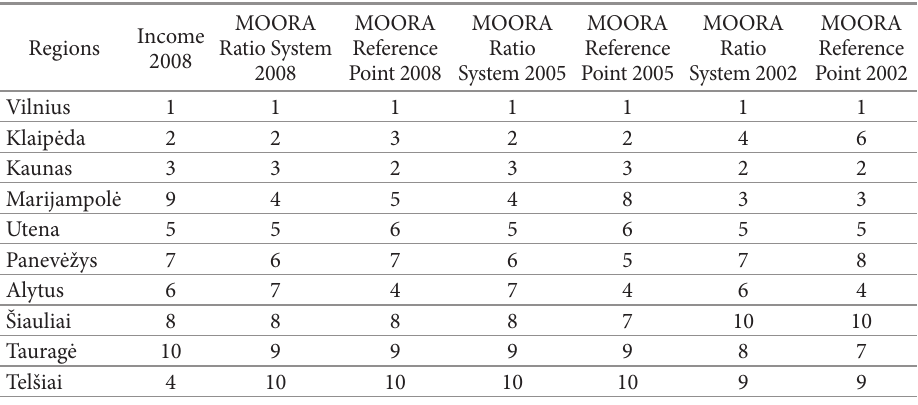
Table 5. Ranking of the Lithuanian Counties after their general Well-Being MOORA MOORA MOORA MOORA MOORA Income Ratio System Reference Ratio Reference Ratio Regions 2008 2008 Point 2008 System 2005 Point 2005 System